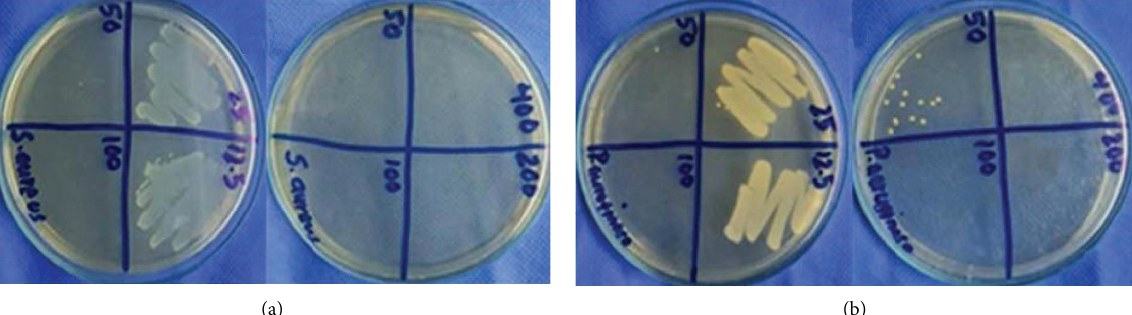
Figure 16: Determination of MBC of AgNPs against S. aureus (a) and P. aeruginosa (b). Te MBC of AgNPs against both was found to be 100 μ